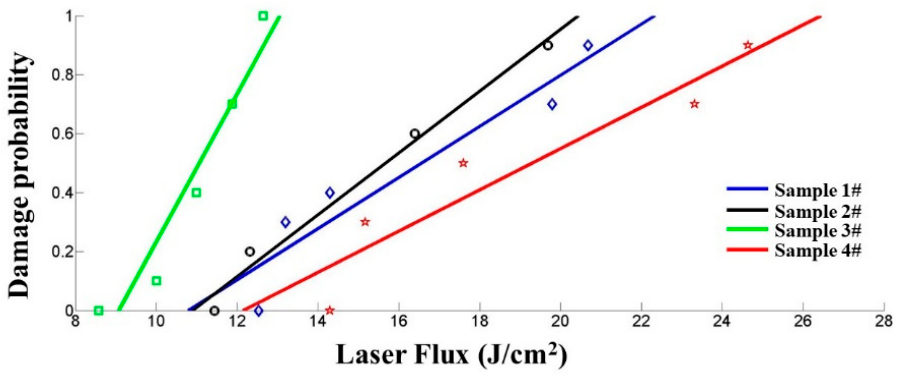
Figure 5. Fitting curves of laser damage threshold.